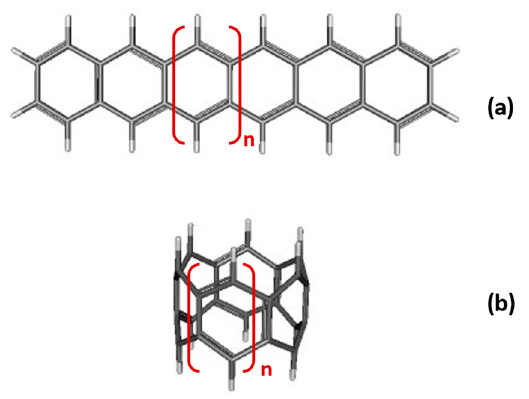
Figure 1. Chemical structure of: ( a ) [n]-acenes ; ( b ) [n]-CC carbon nanobelts. In both cases, n is the number of fused rings.